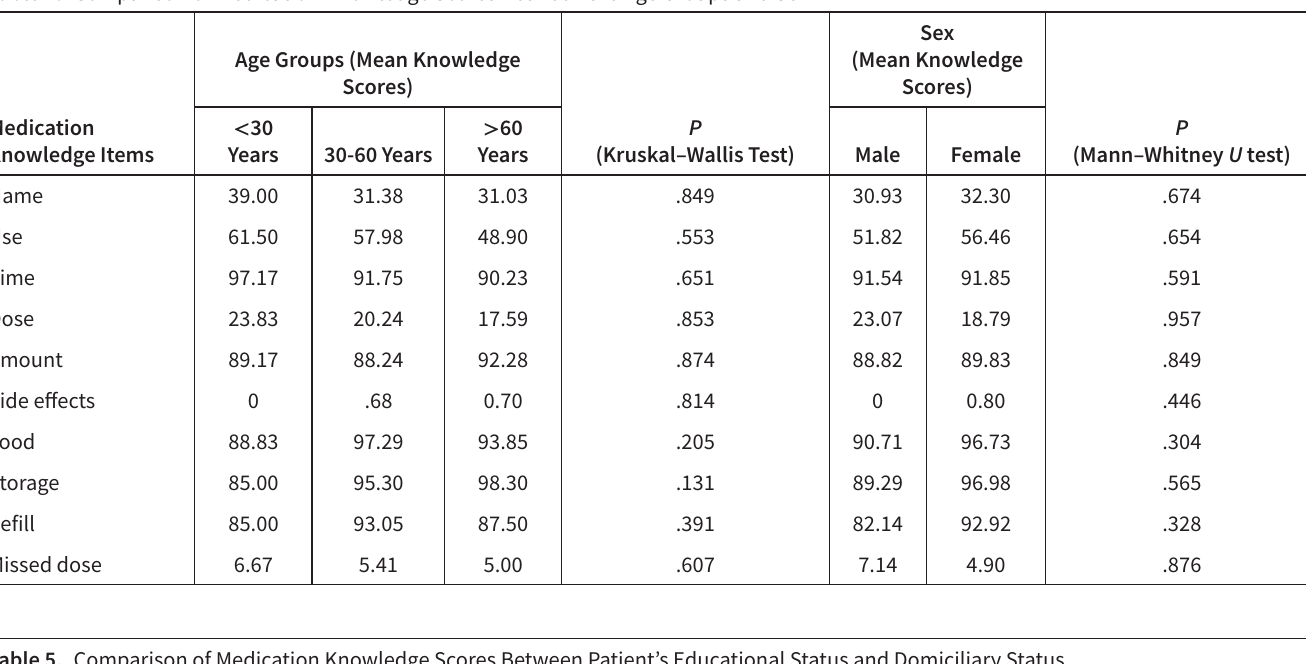
Educational Status (Mean Knowledge